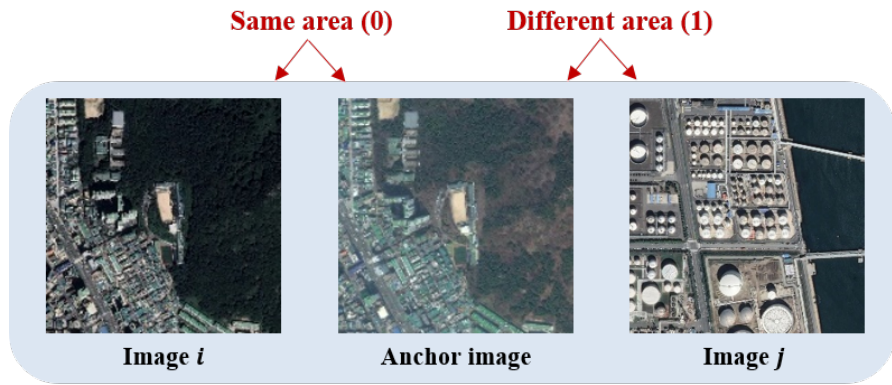
Figure 6. Data tuple example of Step 1. The data tuples consist of the anchor image, image i , and image j . Image i is taken from the same area of the anchor image, and image j is taken from different areas of the anchor